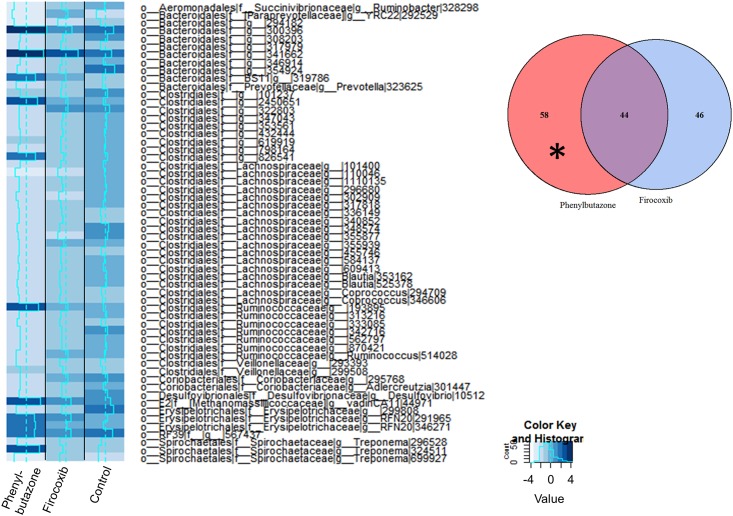
The directionality of the DE OTUs unique to the phenylbutazone group are mirrored in the firocoxib group and represent similar families of bacteria albeit with different OTU assignment.Heatmap showing log2 fold-change of DE OTUs in phenylbutazone-treated horses only (left column) after 10 days of administration. The log2 fold change of these same OTUs are shown for firocoxib-treated horses (middle column) and control horses (right column) for comparison although these OTUs were not DE in these groups. Dashed line in center of each heatmap column represents log2 fold change of 0 (i.e., no fold change), solid line represents mean log2 fold change specific to each OTU within each treatment group. Asterisk in Venn diagram (inset) visually depicts the source of the 58 OTUs represented in this heatmap.